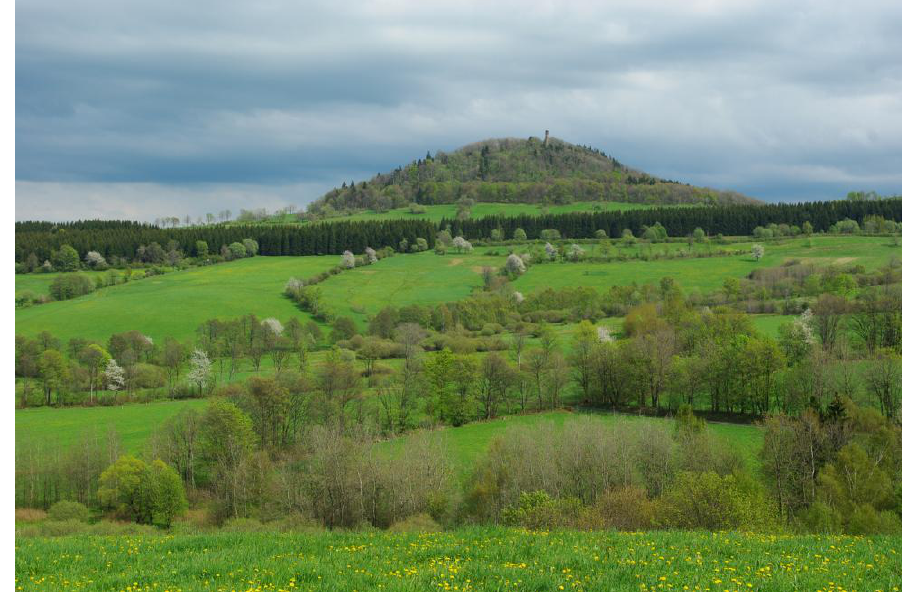
Figure 2: Typical landscape of the Eastern Ore Mountains near the Geisingberg mountain with mountain meadows and stone walls (photo O. Bastian)